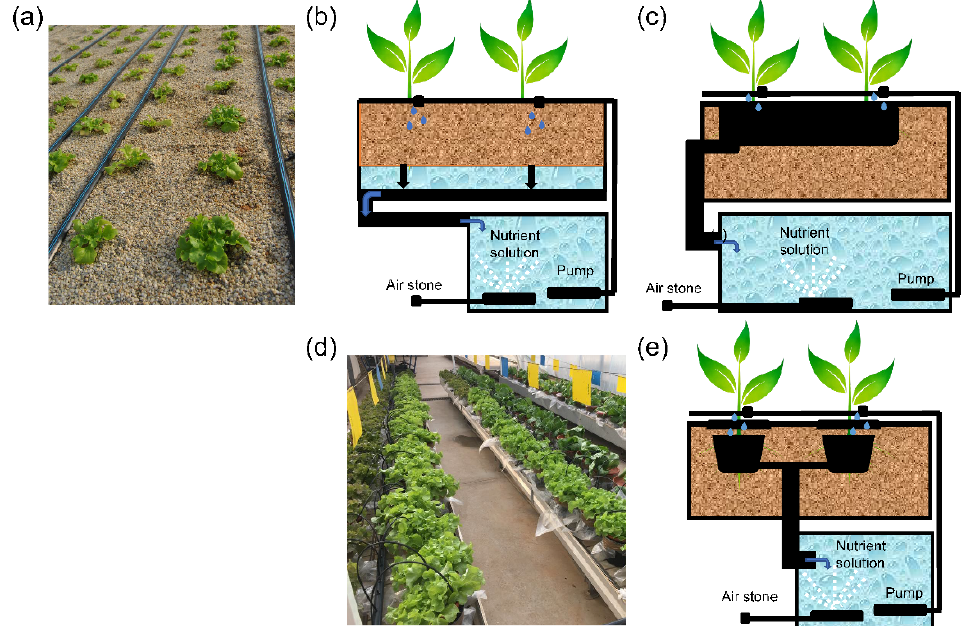
Figure 5. Substrate cultivation systems. ( a ) Lettuce plants growing in sand as an inert substrate, ( b ) a scheme of plants growing directly onto substrate, ( c ) a scheme of plants growing in containers, ( d ) lettuce plants growing in individual containers, and ( e ) a scheme of plants growing in individual containers.